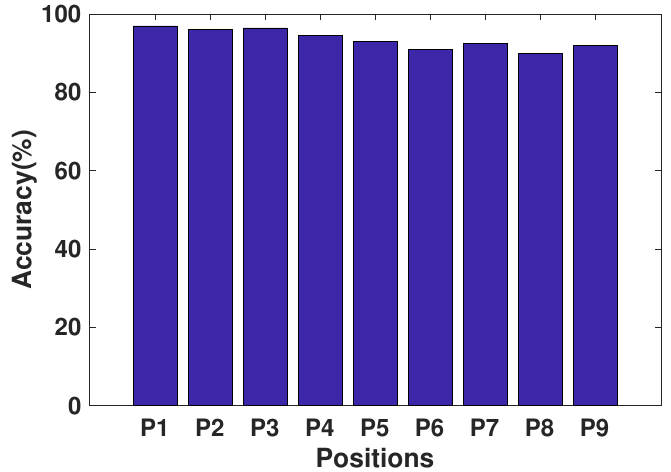
Figure 13. The performance of WiHand under different